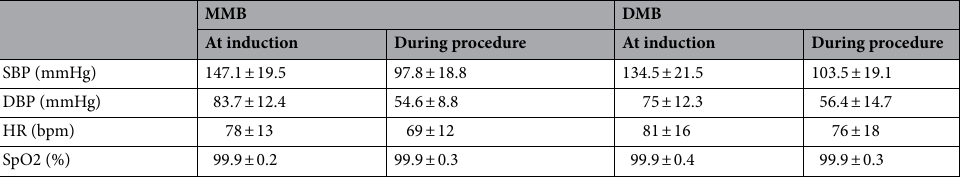
Table 4. Mean haemodynamic parameters of study samples. SBP systolic blood pressure; DBP diastolic blood pressure, HR heart rate, SpO2 peripheral capillary oxygen saturation.